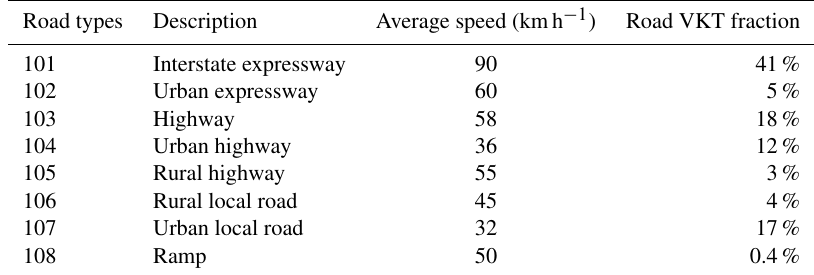
Table C1. Eight road types with assigned average vehicle operating speed and VKT